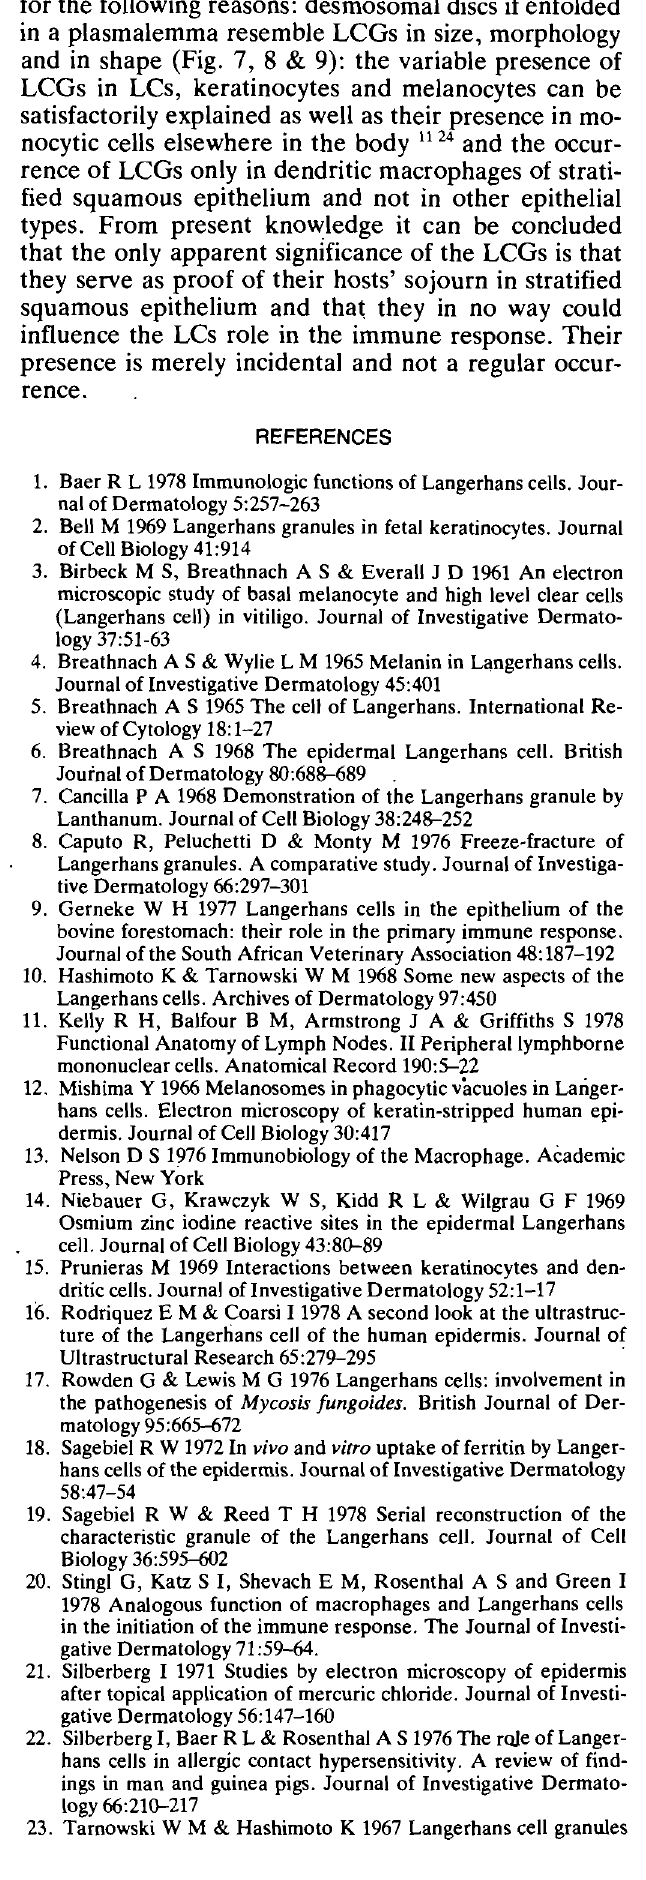
Fig. 10. A dendritic macrophage forcing its way between the epithe lial cells of rumen epithelium. The attenuated tentacle con tains only free ribosomes (see also Fig. 12) while the classi cal organelles are restricted to the main cell body. x 12,300. Fig. 11. A dendritic'macrophage with rarely occurring phagosomes - (arrow) and small Iysosomes (L). It is also in close contact with a T-Iymphocyte on the left and close to another one on the right. They are'separated from the basal lamina (arrow) by a thin ,layer of keratinocyte cytoplasm which on the upper right-hand side contains many mitochondria. x 10,900. Fig. 12. Some LCGs in the tip of a LC tentacle. A closely adhering desmosome (arrow) is devoid of its disc. The latter may have been taken up as a LCG. x 33,750. Fig. 13. A dendritic macrophage revealing mitochondria (M), Golgi apparatus (G), strands of smooth endoplasmic reticulum (ER), free ribosomes (R), some electron dense Iysosomes (L) and total absence of desmosomes between itself and the keratinocytes. x